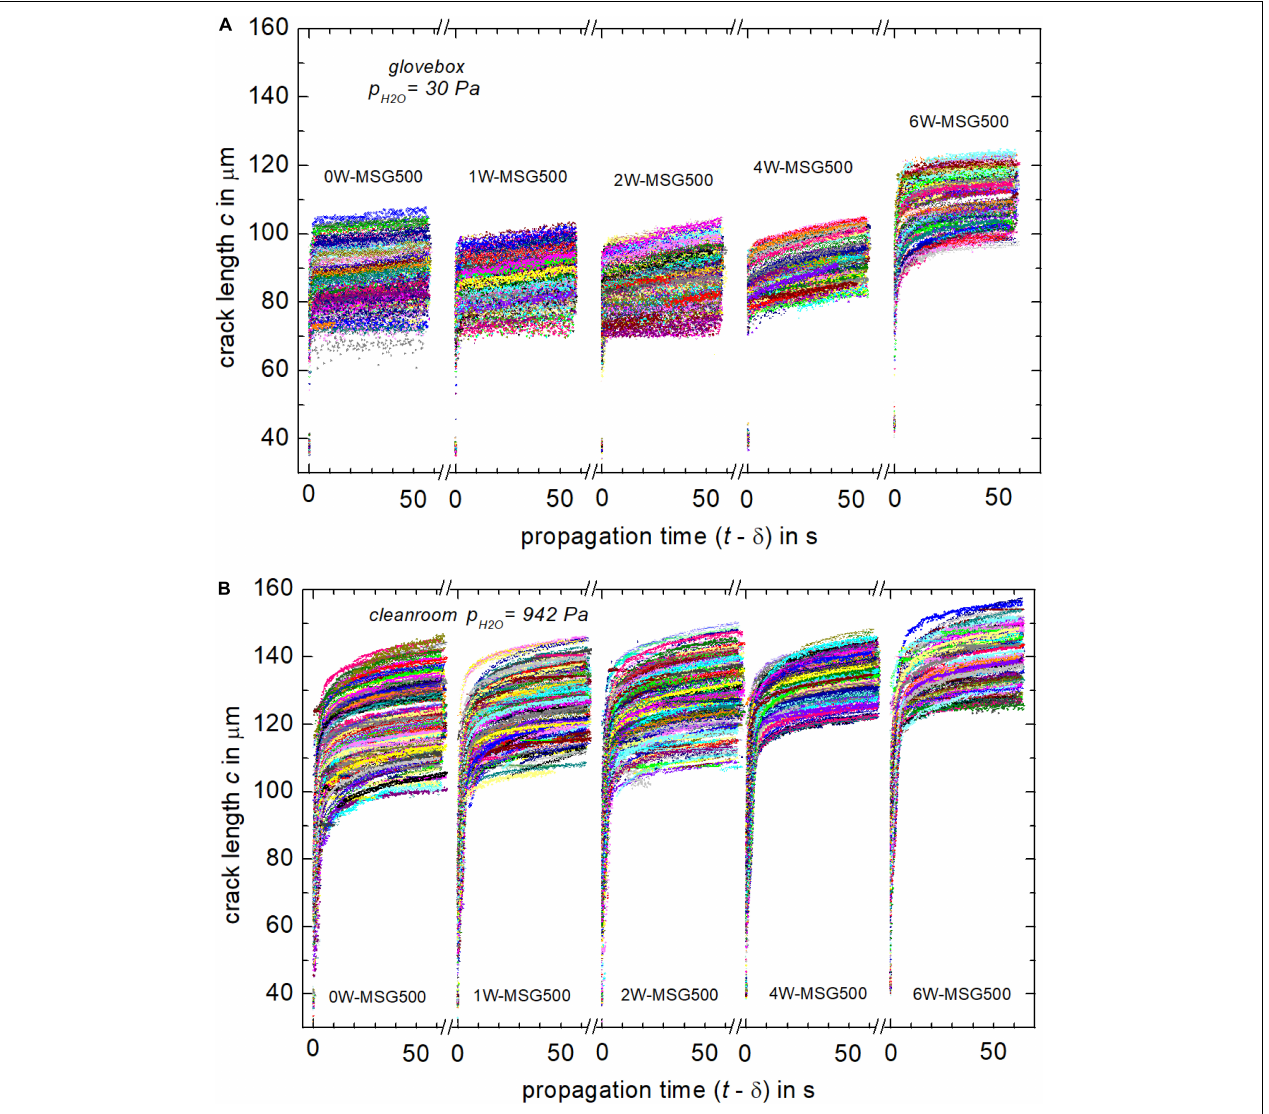
FIGURE 3 | Length vs. propagation time of cracks grown in hydrous glasses in 30 Pa partial pressure of H 2 O (A) and in 942 Pa partial pressure of H 2 O (B)